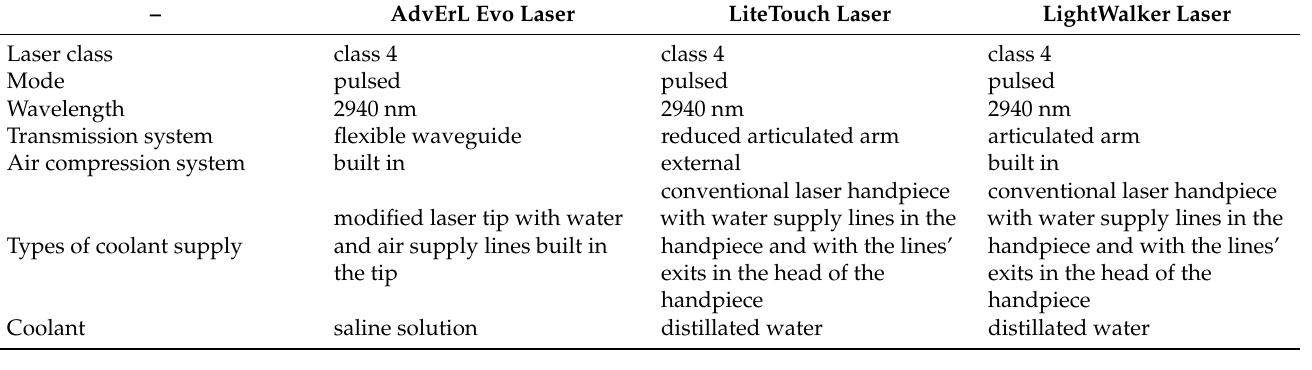
Table 1. The characteristic of three common erbium lasers used in dentistry and compared in the study. –